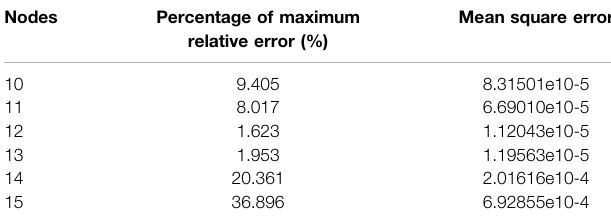
TABLE 1 | Prediction error of BPNN with different hidden layer nodes.